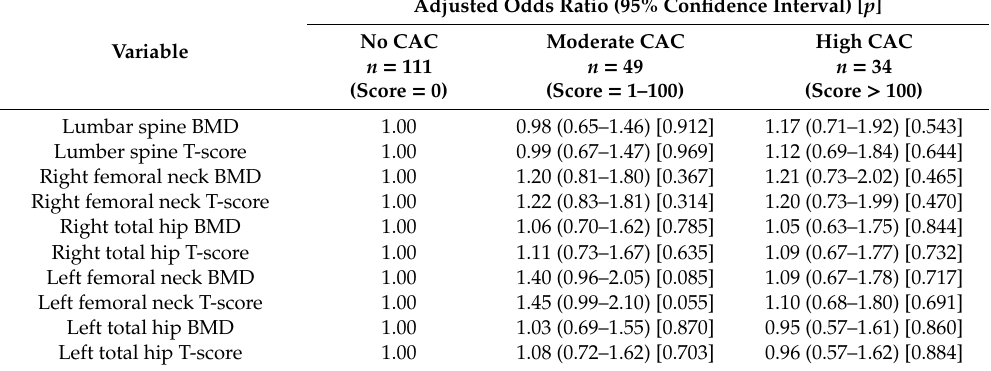
Table 3. Multinomial logistic regression analysis of the association of BMD and T-score with CAC in patients with